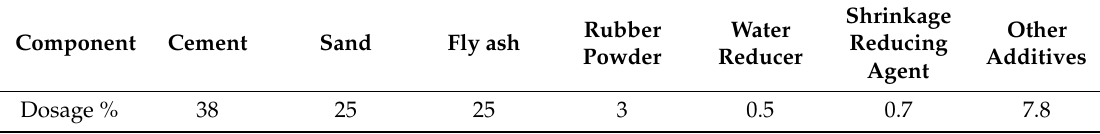
Table 3. The components of the powder mortar.